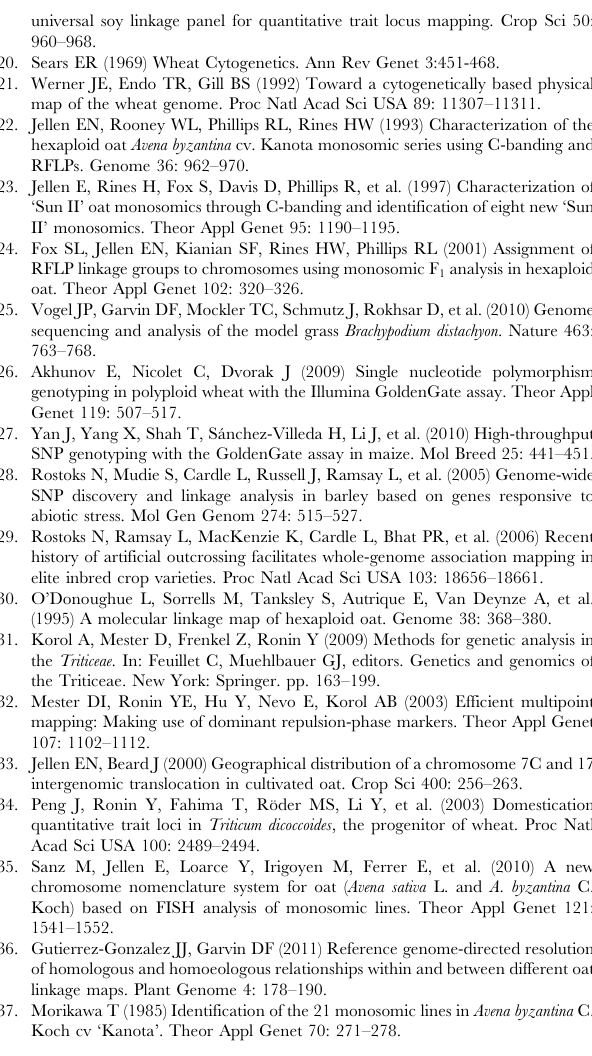
Figure S3 SNP deletion analysis of monosomic hybrid stocks representing chromosomes 6C and 9D. (TIF) Table S1 Correspondence of consensus chromosomes with published KO linkage groups. (DOCX) Dataset S1 Pedigree data for 20 genotypes selected for transcriptome sequencing and SNP identification and for 109 genotypes selected to represent genetic diversity in North American oat germplasm. (XLSX) Dataset S2 Consensus map and component maps from six bi-parental mapping populations, including original SNP genotype calls for component mapping populations. (XLSX) Dataset S3 Details for regions of sequence similarity between SNP markers on 21 chromosomes from an oat consensus map and chromosomes from the sequenced genomes of Brachypodium distachyon and Oryza sativa . (XLSX)